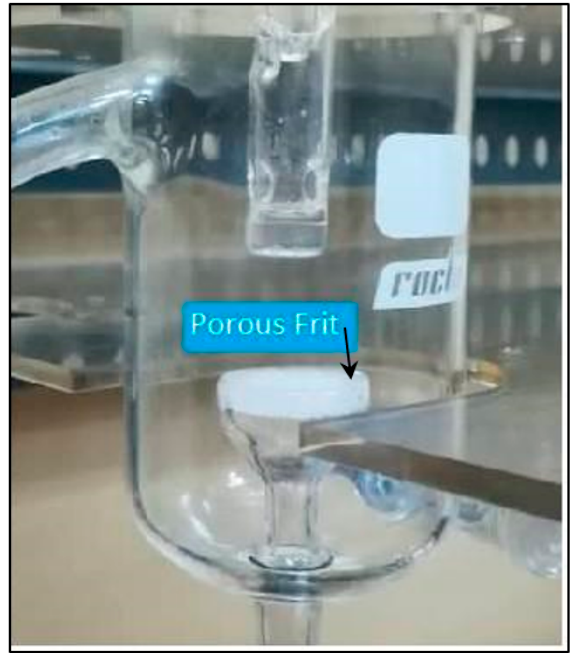
Figure 3. Porous frit P2 in the mixing column.